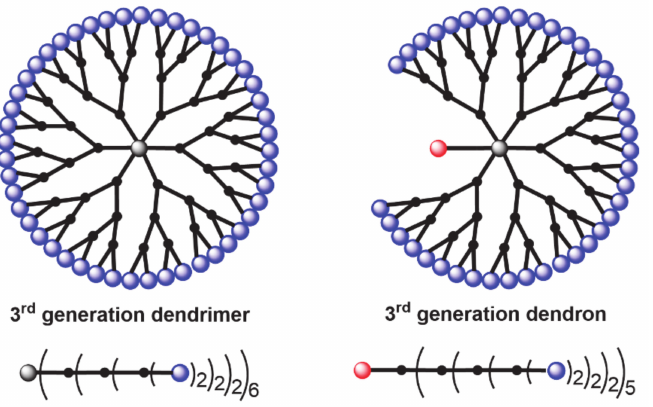
Figure 1. Schematized drawing of third generation dendrimer and dendron, built from an hexafunc- tional core such as N 3 P 3 . Full structure, and linear structure with